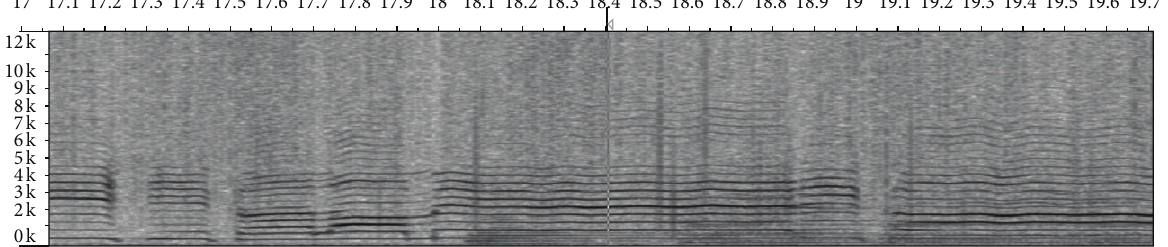
Figure 3: The figure shows an example of broadband noise and impulsive noise in a spectrogram of an audio signal extracted from a 78rpm shellac disc. Broadband noise is due to the granular nature of the material and its degradation over time. Time (seconds) is shown on the 𝑥 - axis; frequency (Hertz) is shown on the 𝑦 -axis. The shades of grey color show the amplitude: broadband noise is visible throughout the excerpt from the grey background (in contrast with the darker harmonic frequencies clearly visible up to ∼ 5kHz); impulsive noises correspond to the vertical lines at seconds 18.08, 18.53, and